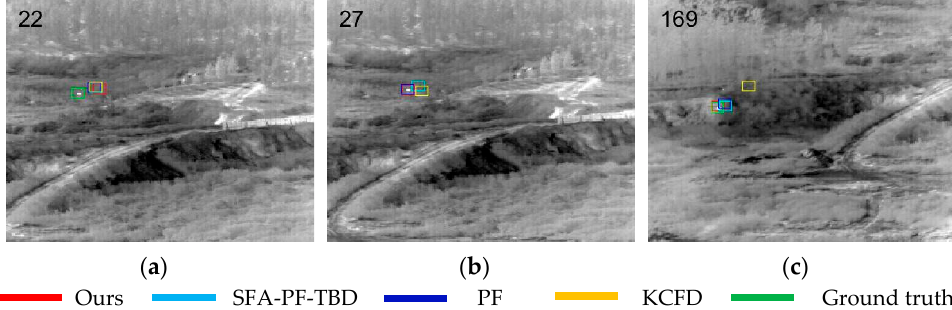
Figure 4. Tracking results of four methods for data18. ( a ) Results at frame 22; ( b ) results at frame 27; ( c ) results at frame 169.